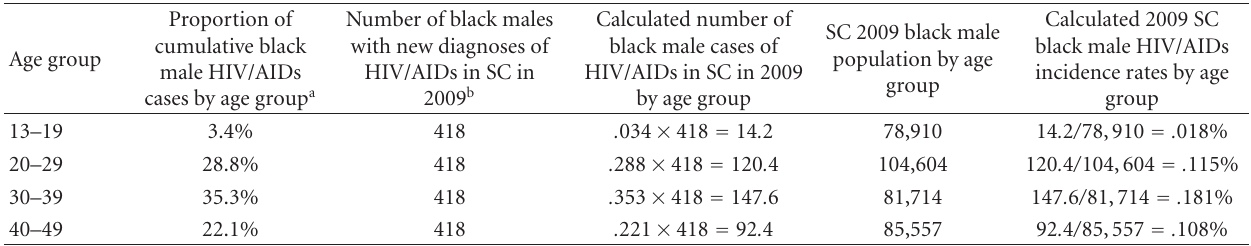
Table 1: Example calculation of age and race/ethnicity specific HIV incidence